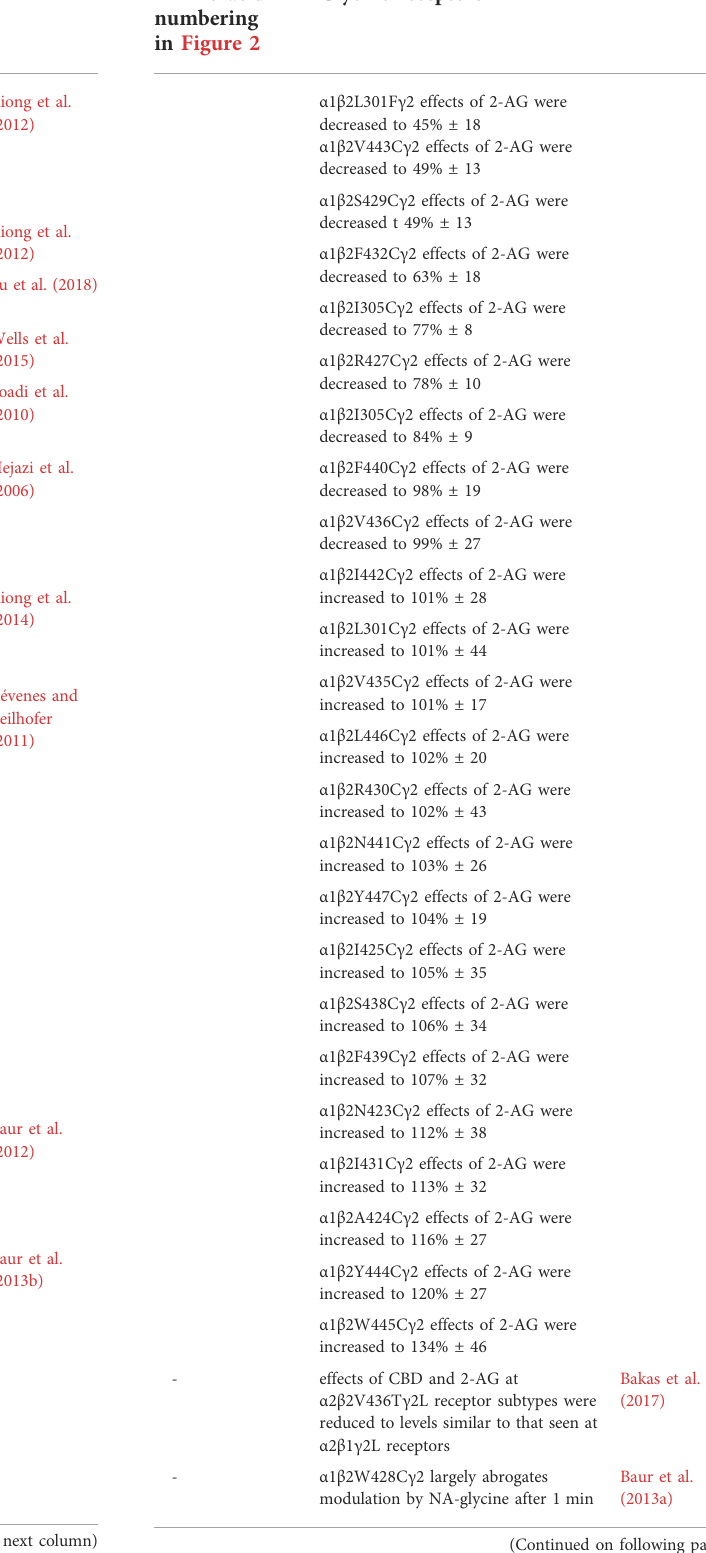
TABLE 1 Mutational analysis of candidate binding